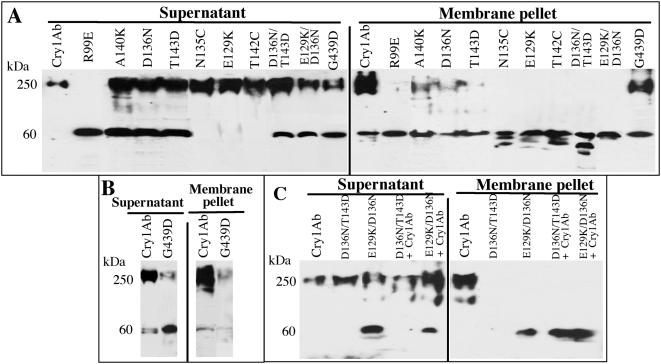
Oligomerization of Cry1Ab proteins.Panel A, Cry1Ab and mutant protoxins were proteolytically activated with M sexta midgut proteases in the presence of SUV liposomes and scFv73 antibody. Membrane pellets were recovered by centrifugation and the toxin detected by Western blot using an anti-Cry1Ab antibody in the supernatant and in the membrane fraction. The oligomeric structure of 250-kDa of the Cry1Ab is observed inserted into the membrane pellet, in contrast with the helix α-4 mutants, that remains in the soluble fraction. The mutant R99E, located in helix α-3 did not form oligomeric structures. Panel B, Oligomerization of Cry1Ab and mutant G439D proteins performed as above but in the presence of the cadherin CR12 fragment instead of scFv73 antibody. Under these conditions the oligomerization of the Cry1Ab wild type is observed inserted into the membrane and oligomerization of G439D mutant was severely reduced. Panel C, Oligomerization of the mixtures of 1∶1 Cry1Ab: Mutant proteins performed as in Panel A. The oligomer of double mutants or in the 1∶1 mixture of Cry1Ab with the double mutants is observed in the soluble fraction.